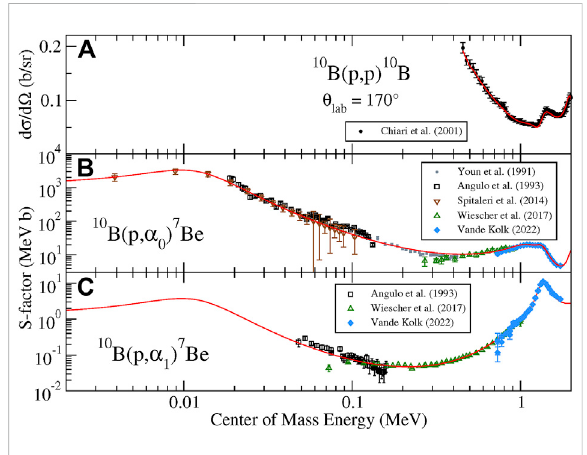
FIGURE 1 Simultaneous R -matrix fi ts to (A) the scattering data of Chiari et al. [20], (B) the 10 B ( p , α 0 ) 7 Be (transition to the ground state of 7 Be) data of Youn et al. [21], Angulo et al. [22], Wiescher et al. [18], Spitaleri et al. [23], and Vande Kolk et al. [14] and (C) the 10 B ( p , α 1 ) 7 Be (transition to the fi rst excited state of 7 Be) data of Angulo et al. [24], Wiescher et al. [18], and Vande Kolk et al.